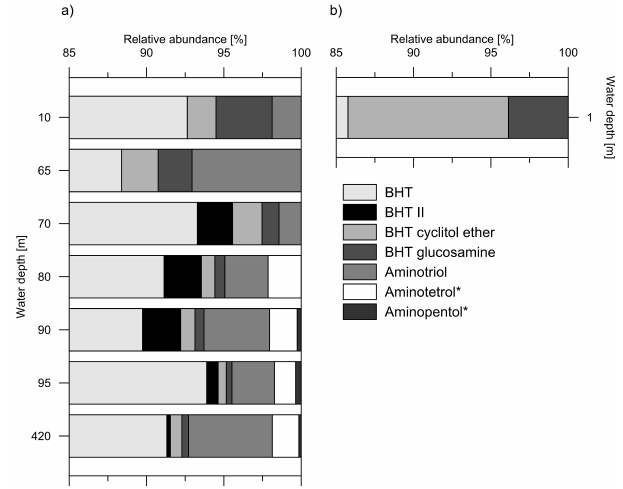
Figure 6. Relative abundances of individual BHPs (as percent of the total) of (a) the Landsort Deep water column and (b) the Gotland Deep cyanobacterial bloom. Note that [%] axes start at 85%. An asterisk indicates data taken from Jakobs et al.